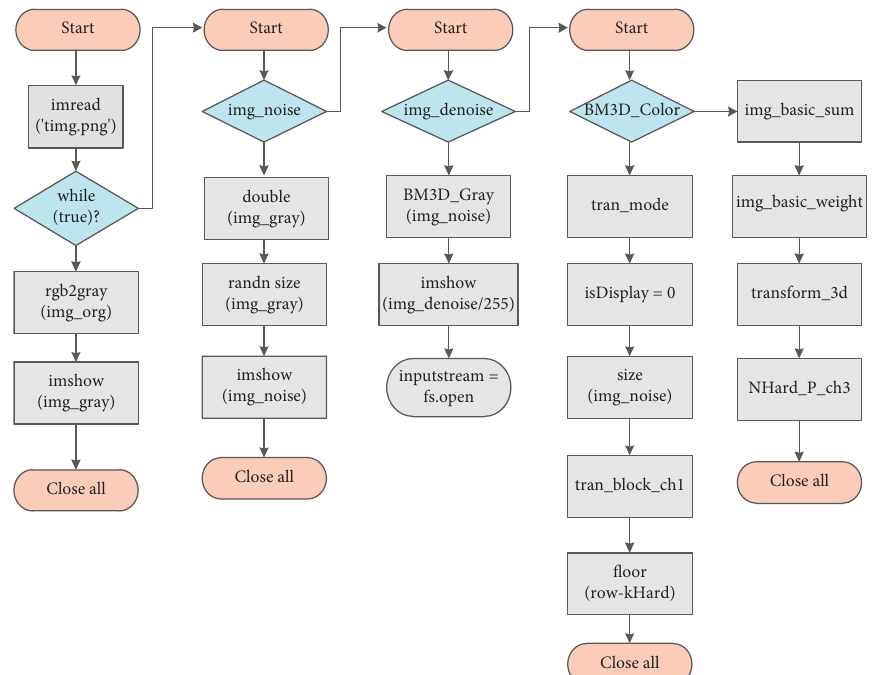
Figure 2: Feature point detection algorithm for image sculpture building.